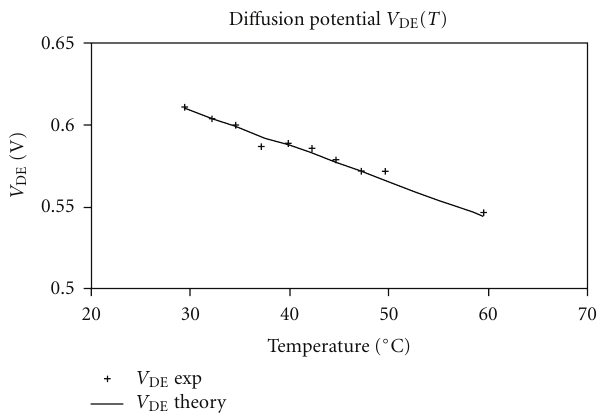
Figure 7: Variation of di ff usion potential versus